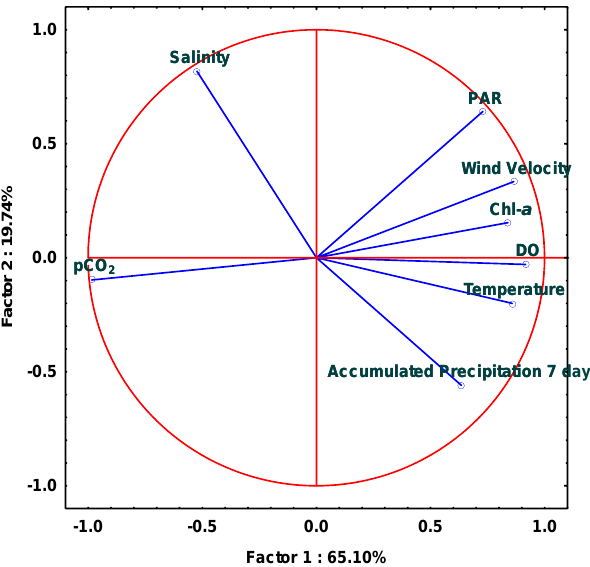
Figure 8. Principal components analysis (PCA) based on mean val- ues for each sampling campaign of the physical and biogeochem- ical properties of the water (temperature, salinity, p CO 2 , DO and Chl a ) and meteorological conditions (wind velocity and accumu- lated precipitation of 7 days before each survey). The data set was normalized by z